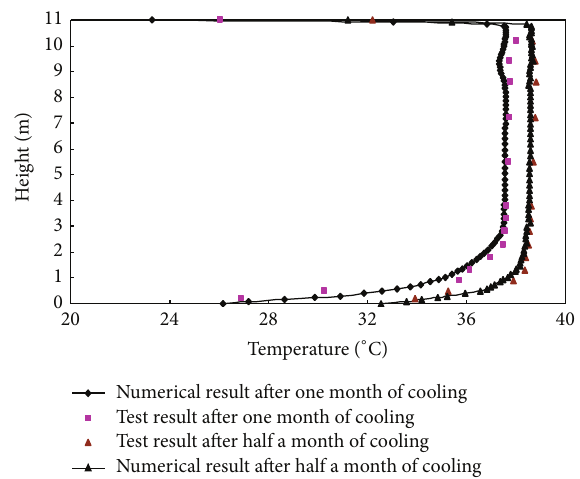
Figure 25: The comparison of tested and numerical results.